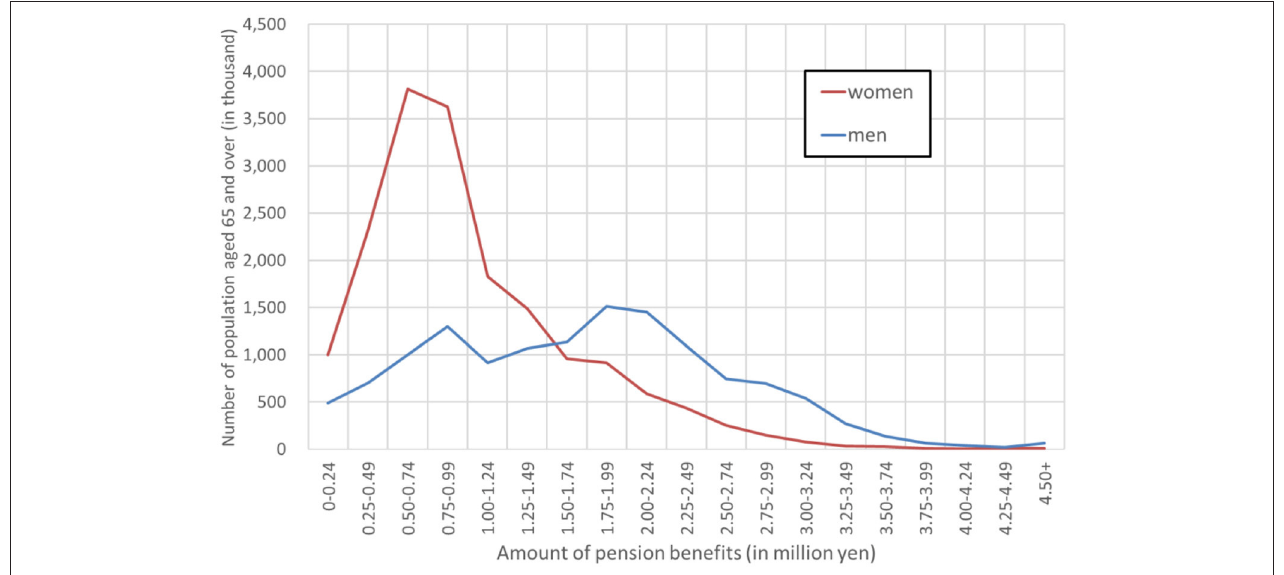
FIGURE 3 | Distribution of pension amounts by gender (2012). Simulation